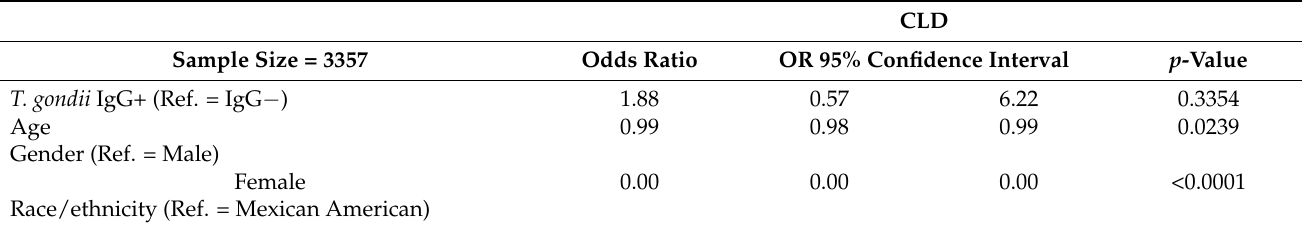
Table 5. Results of binomial logistic regression for CLD and T. gondii (IgG+/IgG − )—adjusted for BMI and demographic